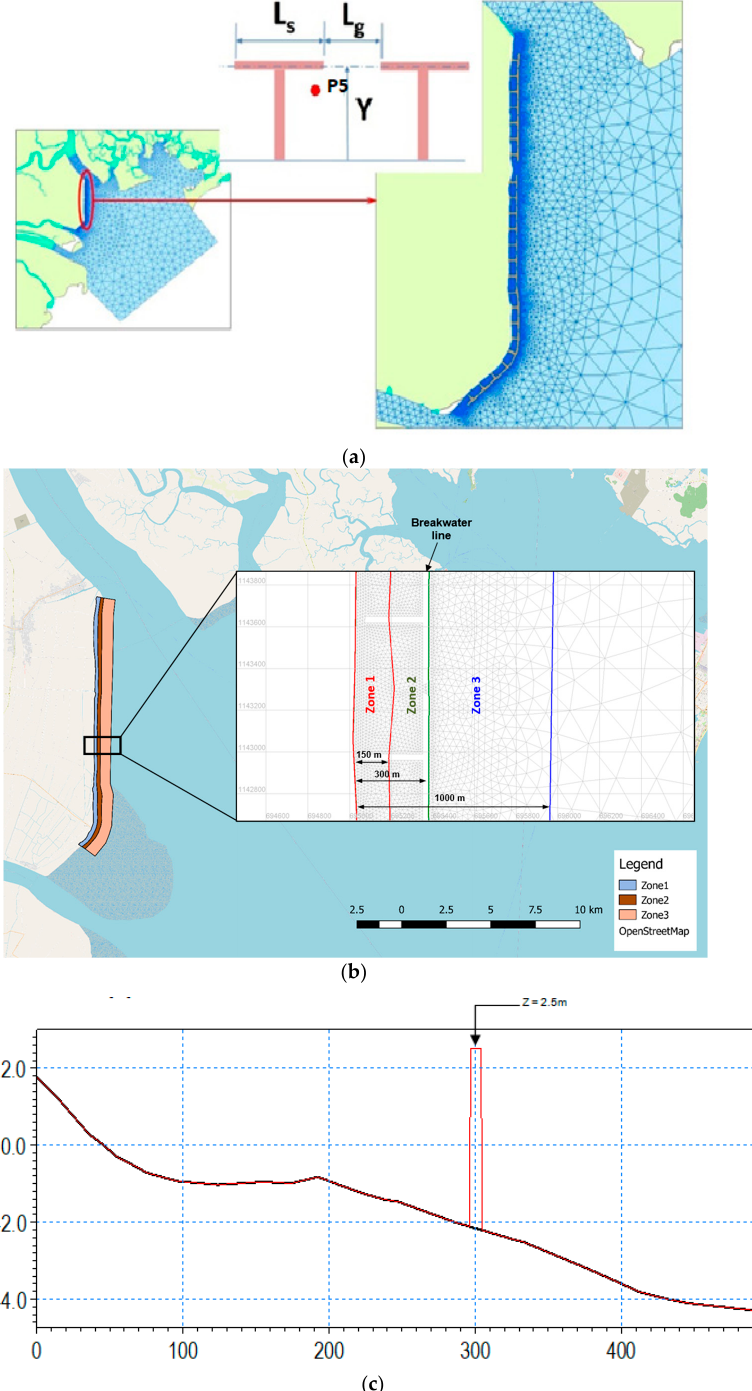
Figure 10. ( a ) Protection measure of T ‐ shape breakwaters ( top ); ( b ) position of zones 1, 2, and 3 ( bottom ), ( c ) beach profile and position of breakwaters.